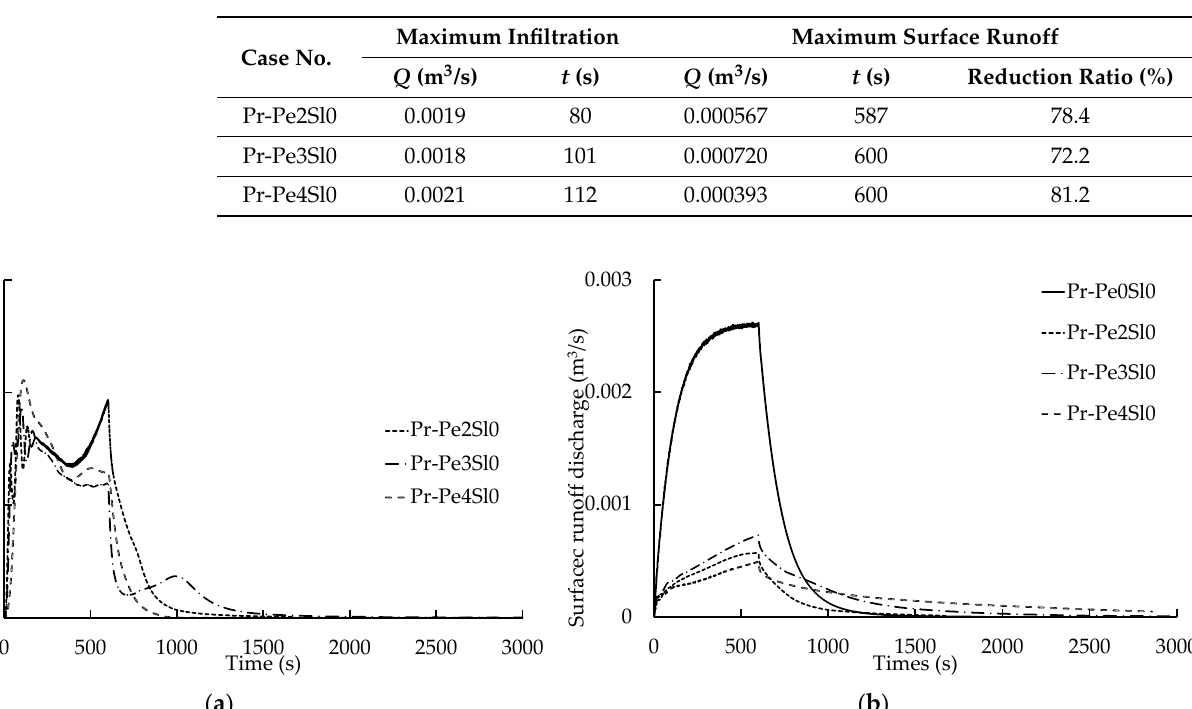
the complex structure design. As a result of simulation according to the permeability of the pavement when designing multiple structures, the highest total amount of infiltration was calculated as 1.11 m 3 for Pr-Pe2Sl0 due to the high permeability of the pavement. As a result of simulation of Pr-Pe4Sl0, Pr-Pe4Sl3, and Pr-Pe4Sl5, the infiltration amount decreased with the increase of the transverse slope. As shown in Table 9, this was identified as a phenomenon caused by an increase in the surface runoff with an increase of the